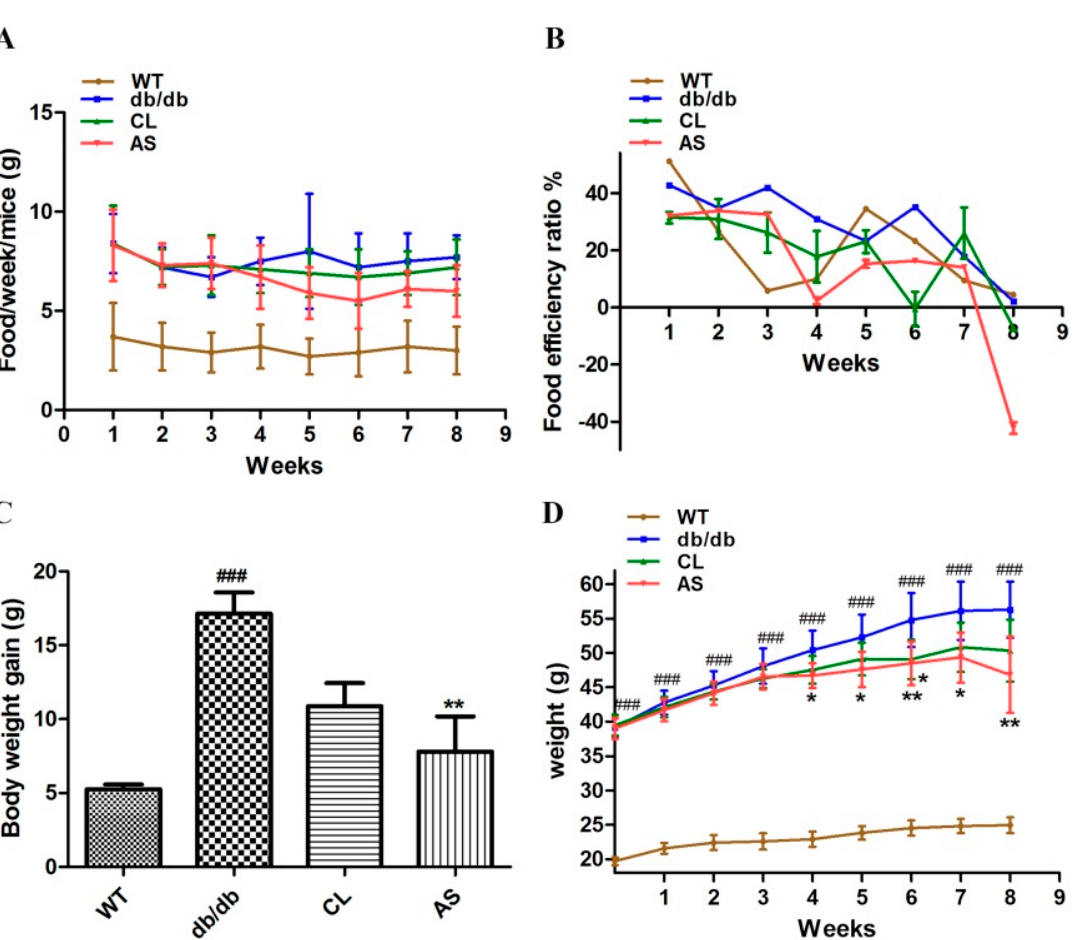
Figure 2. AS suppressed weight gain in db/db mice. Mice were divided into four groups: WT control; obese db/db control; CL treatment (100 mg/kg/day) and AS treatment (540 mg/kg/day). The drugs were oral gavage for eight weeks. ( A ) food intake was recorded weekly; ( B ) food efficiency ratio was calculated as body weight gain divided by food intake; ( C ) change in body weight was measured weekly; and ( D ) body weight gain was measured weekly. Values are expressed as mean ± SEM ( n = 24). * p < 0.05, ** p < 0.01 vs. db/db group; ### p < 0.001 vs. WT group.